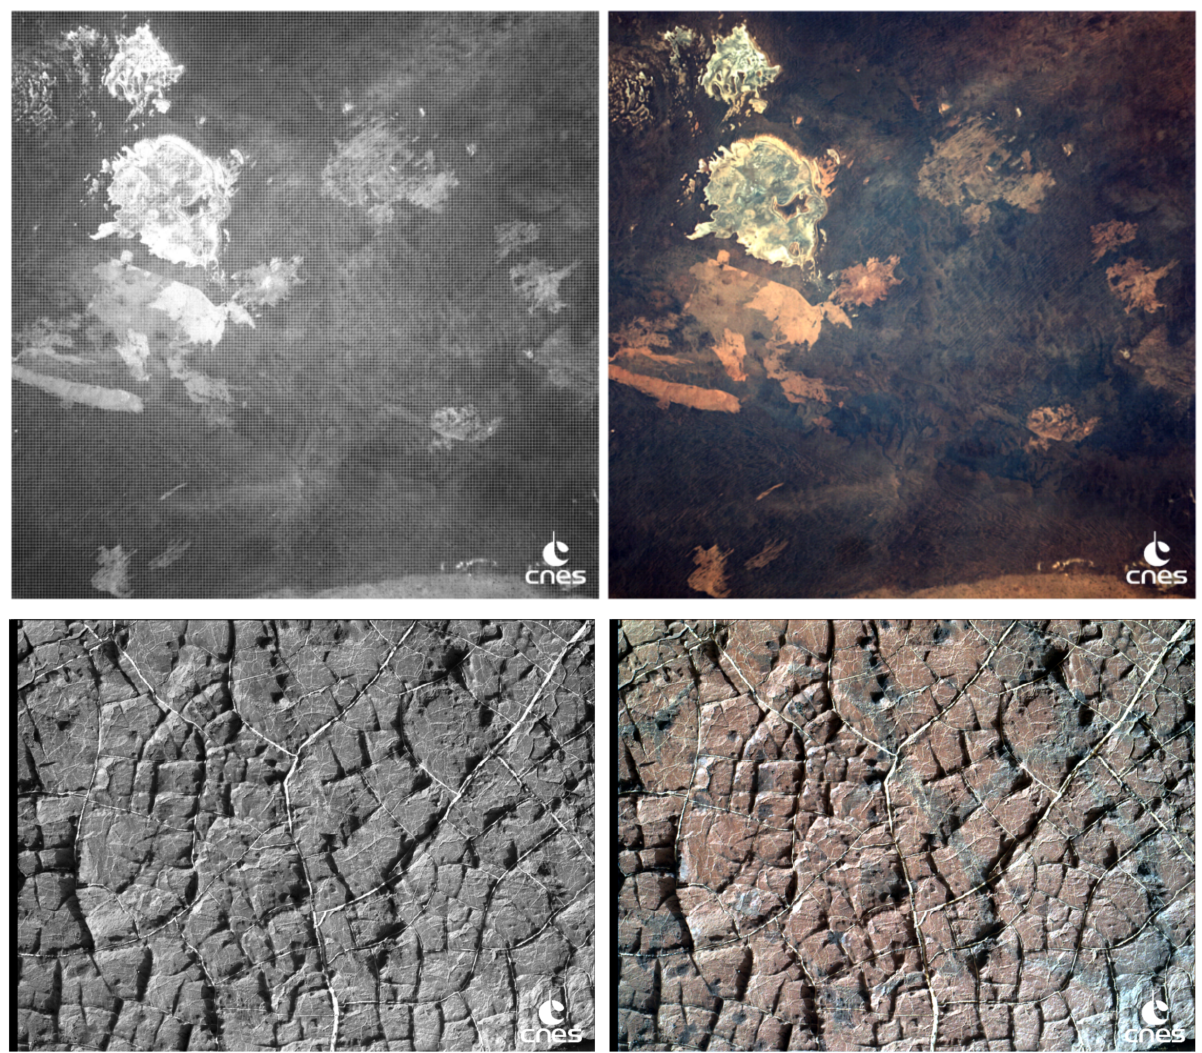
Figure 8. ( Top ) Eyesat image taken over Lake Maurice, Australia, in December 2019 (local time around 5:30). Copyright: CNES. ( Bottom ) MAHLI image over Beech Mountain. ( Left ) Raw Bayer image. ( Right ) Coloured image post-processed with the chain presented here. White balance is not performed in these images after